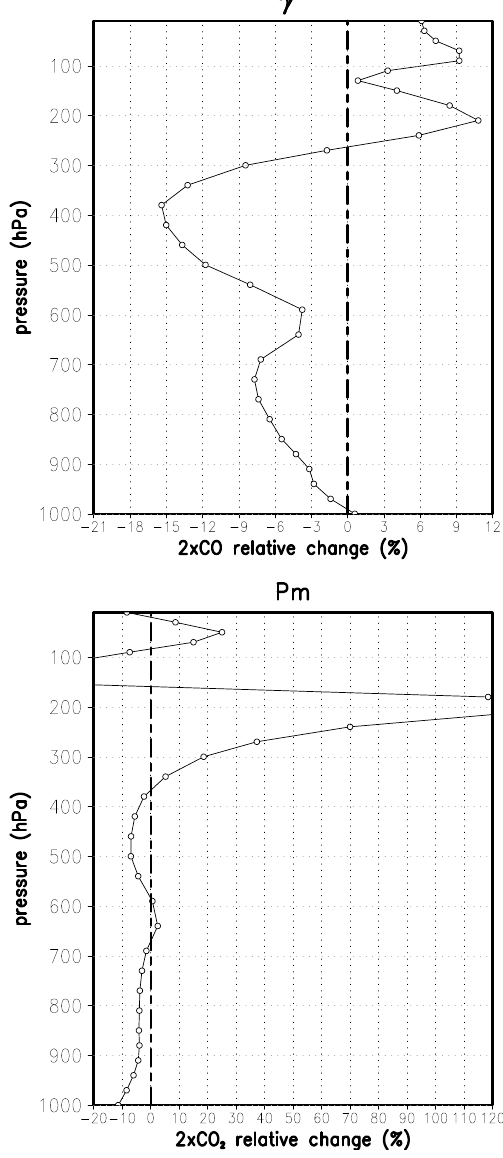
Fig. 8. Relative change of the vertical profile of gamma, γ (above) and of P m (below) when doubling CO 2 concentrations (difference divided by the 1 × CO 2